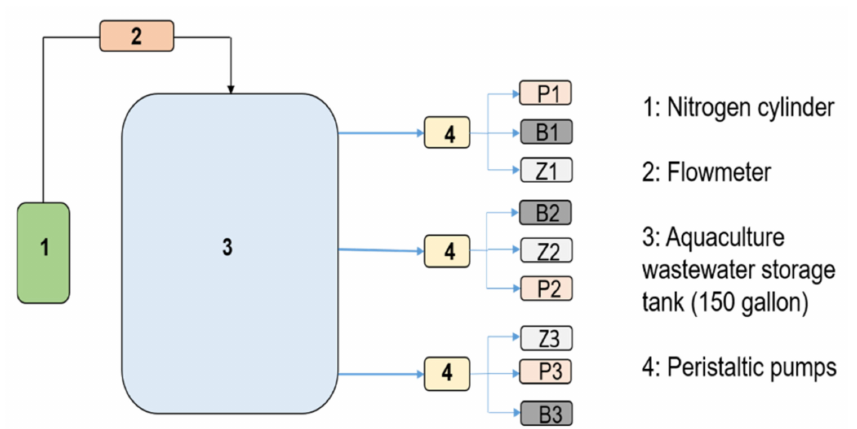
Figure 3. The layout of the different components of the experimental